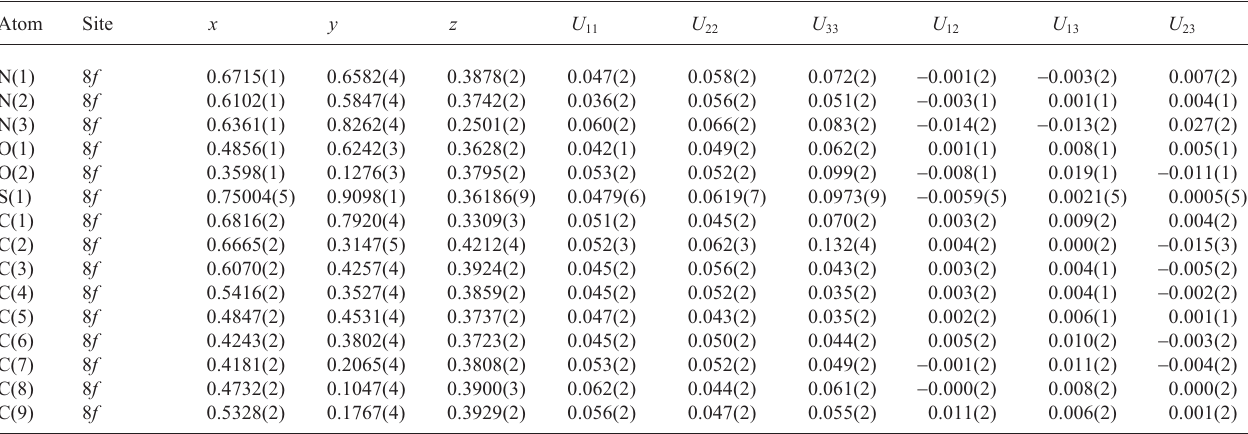
Table 3. Atomic coordinates and displacement parameters (in Å 2 )